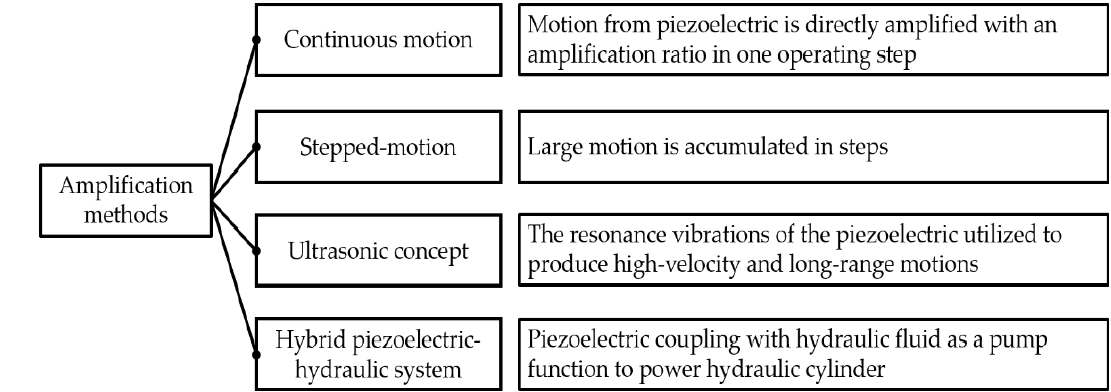
Figure 5. Summary of amplification methods.